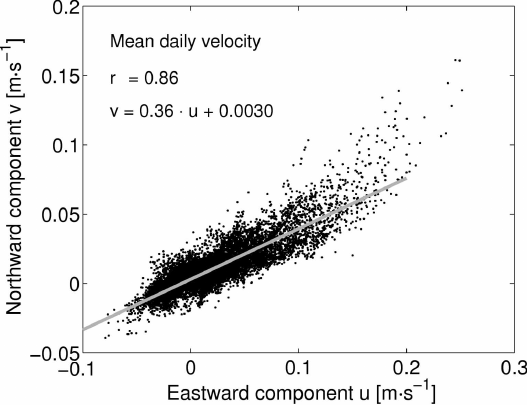
Fig. 3. Mean daily current components near the ferry route calcu- lated by General Estuarine Transport Model (GETM) for the first 20 weeks in 2004. Considered GETM grid points are indicated as black dots in Fig.